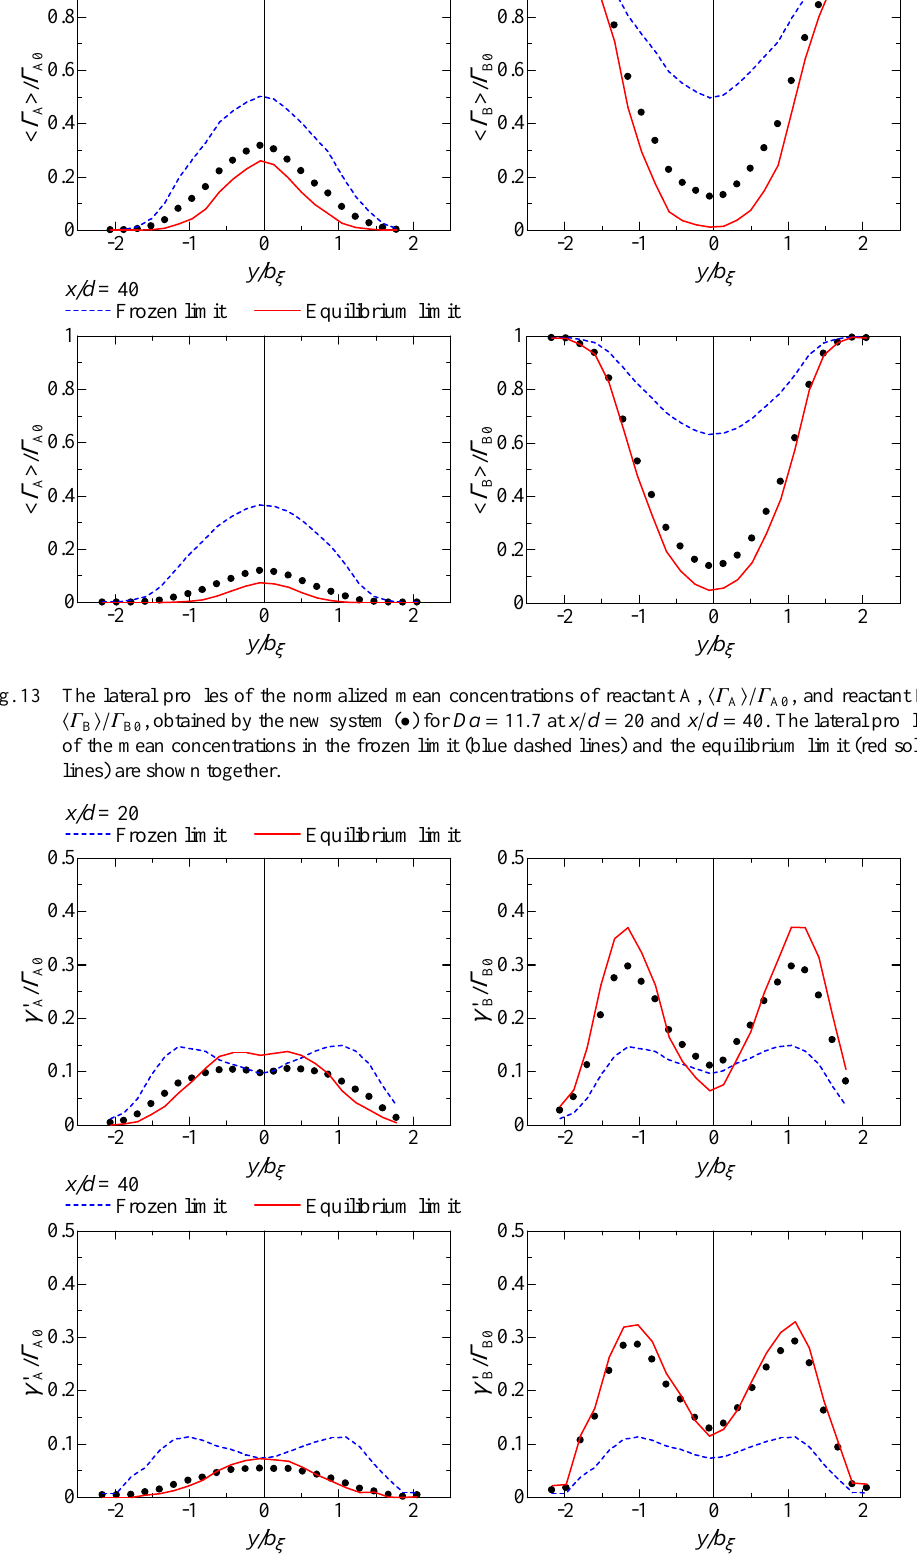
Fig. 14 The lateral profiles of the normalized rms values of concentration fluctuation of reactant A, (cid:13) A ′ =(cid:0) A0 , and reactant B, (cid:13) B ′ =(cid:0) B0 , obtained by the new system ( (cid:15) ) for Da = 11 : 7 at x = d = 20 and x = d = 40. The lateral profiles of the rms values of concentration fluctuations in the frozen limit (blue dashed lines) and the equilibrium limit (red solid lines) are shown